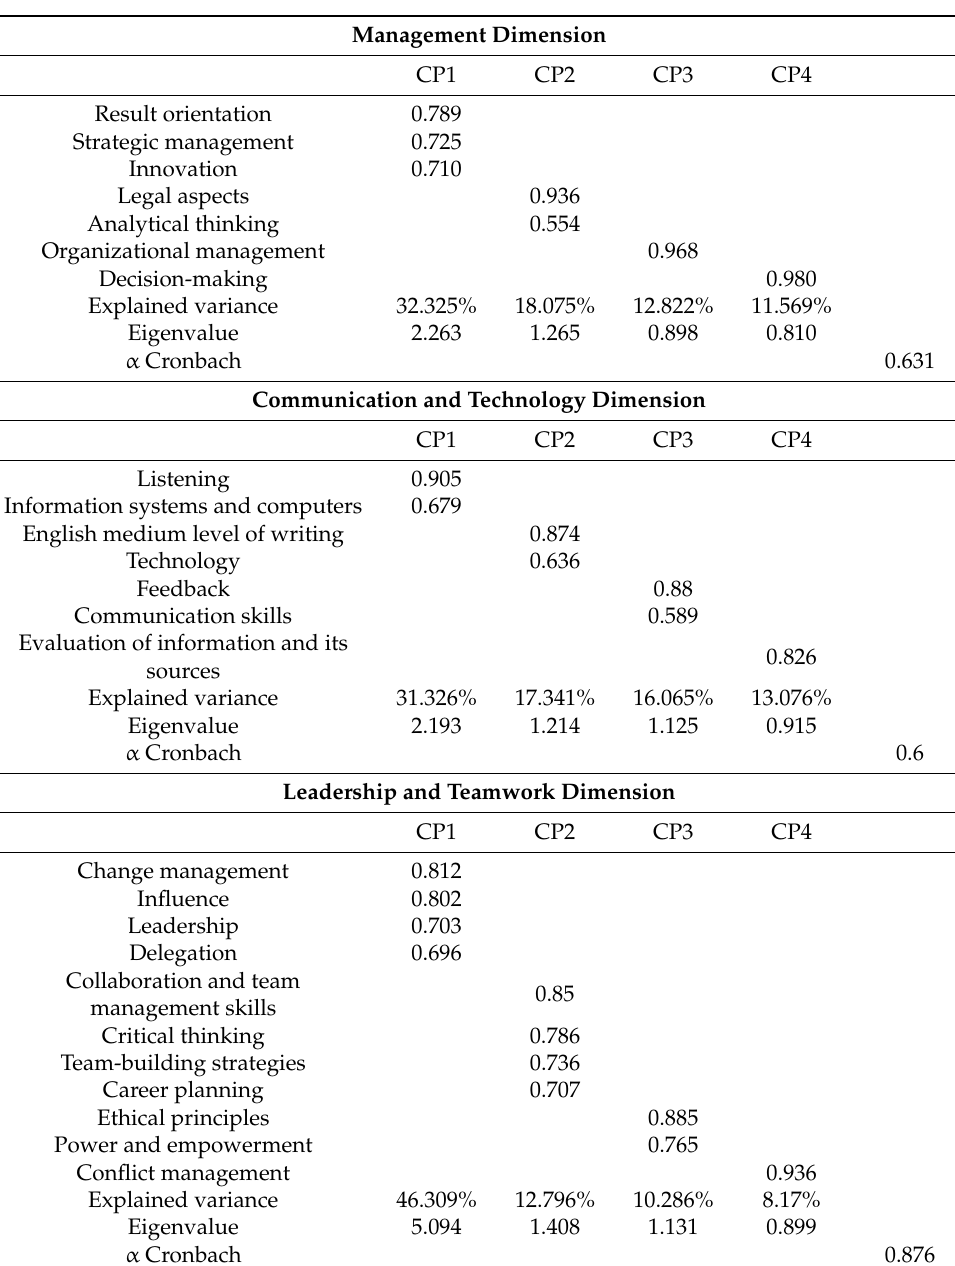
Table 4. Factor structure of the proposed competency